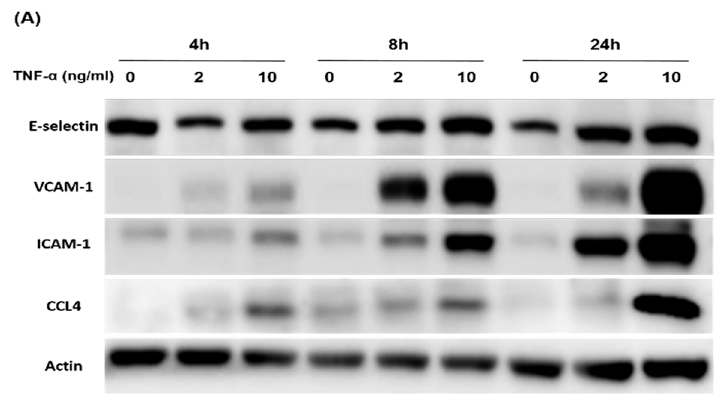
Figure 4. CCL4 blockade down-regulated TNF- α - and oxidized low-density lipoprotein (ox-LDL)- induced matrix metalloproteinase (MMP)2 and MMP9 expression. The CCL4 inhibition groups showed reduced MMP2 and MMP9 expression in plaques ( A , 200× magnification, scale bars = 100 μ m). Quantification of MMP2-positive area/plaque area (%) and MMP9-positive area/plaque area (%) indicating that treatment with 10 μ g CCL4 antibody reduced MMP2 and MMP9 expressions in plaques ( B , n = 6 in each group). # p < 0.05 compared with the IgG 2A isotype control group. MMP9 and MMP2 activities in the culture medium were determined using SDS-PAGE gelatin zymographic analysis ( C , E ). Both MMP2 and MMP9 activities were increased after phorbol 12-myristate 13-acetate (PMA) stimulation. The TNF- α - and ox-LDL-induced MMP2 and MMP9 activities were decreased in the CCL4 siRNA-treated group ( n = 3; D , F ). Basal represented untreated THP-1 cell and control represented THP-1 cell were incubated with PMA to induced M0 phase macrophages. * p < 0.05 compared with the basal group. # p < 0.05 compared with the TNF- α - or ox-LDL-stimulated